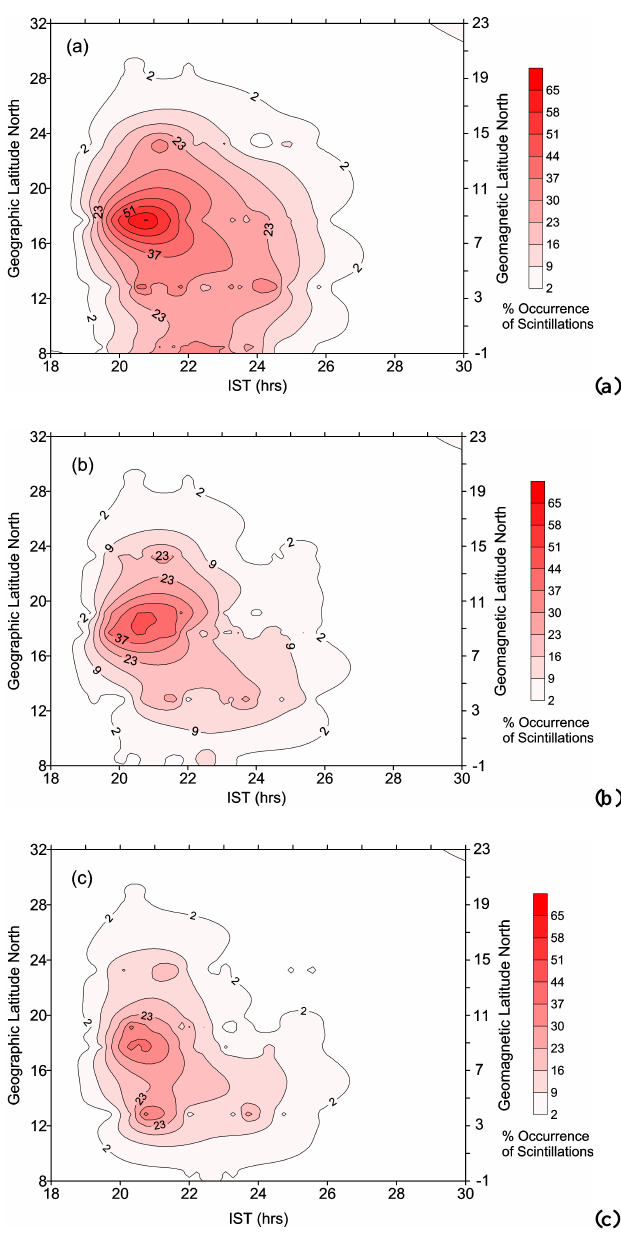
Fig. 3. Temporal and spatial variation of the percentage occurrence of scintillation activity as a function of their intensity over all the Indian stations as observed from GPS S4 index data for the equinox month of March 2004 at power levels of (a) 3 to 6dB, (b) 6 to 10dB and (c) >